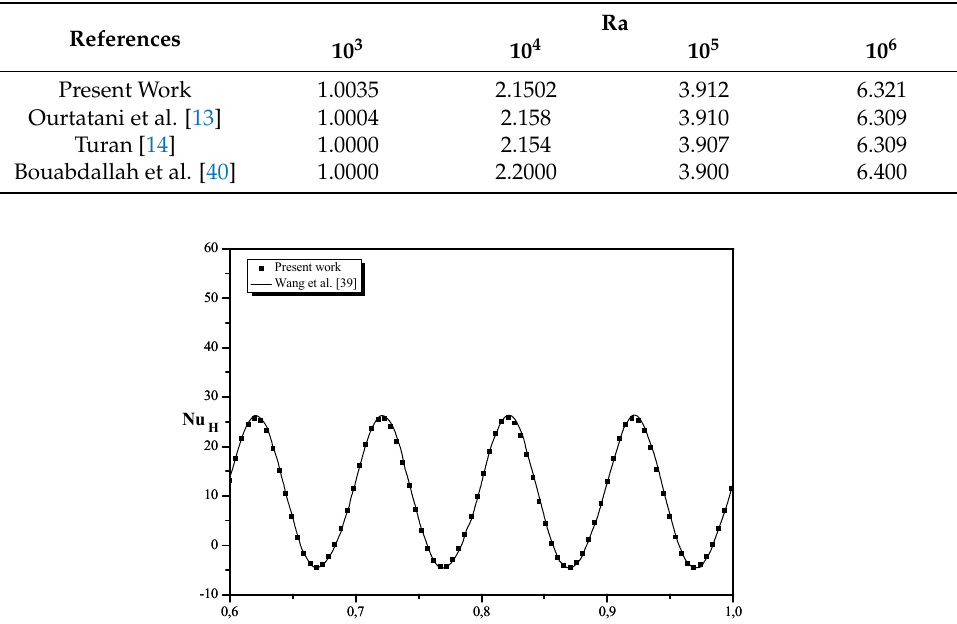
Table 1. Nusselt numbers’ validation.